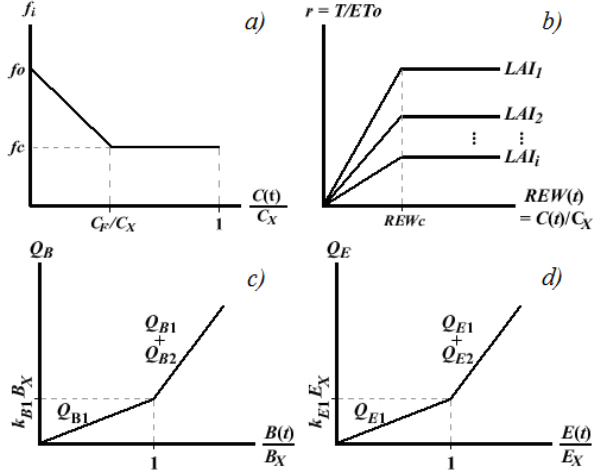
Fig. 4. (a) Infiltration from surface reservoir as a function of soil water content in the non-saturated non-root reservoir. (b) The ratio r = T ET − 1 as a function of relative extractable water REW and for 0 different values of LAI (here, LAI 1 > LAI 2 > ... > LAI i ). (c) Sur- face runoff from the surface reservoir as a function of its water con- tent. (d) Baseflow from the aquifer reservoir as a function of its water